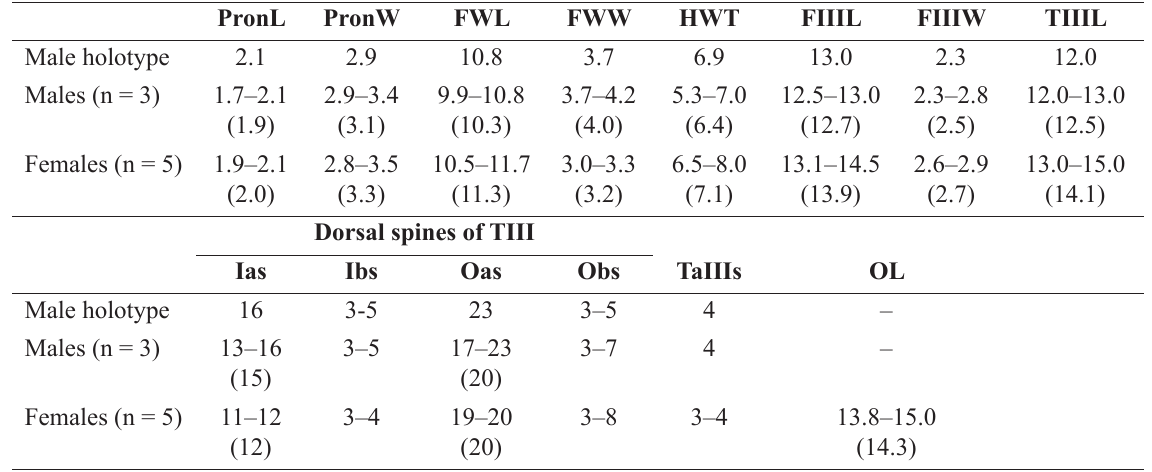
Table 4. Measurements of Nisitrus crucius Robillard & Tan sp. nov. (in mm, means in